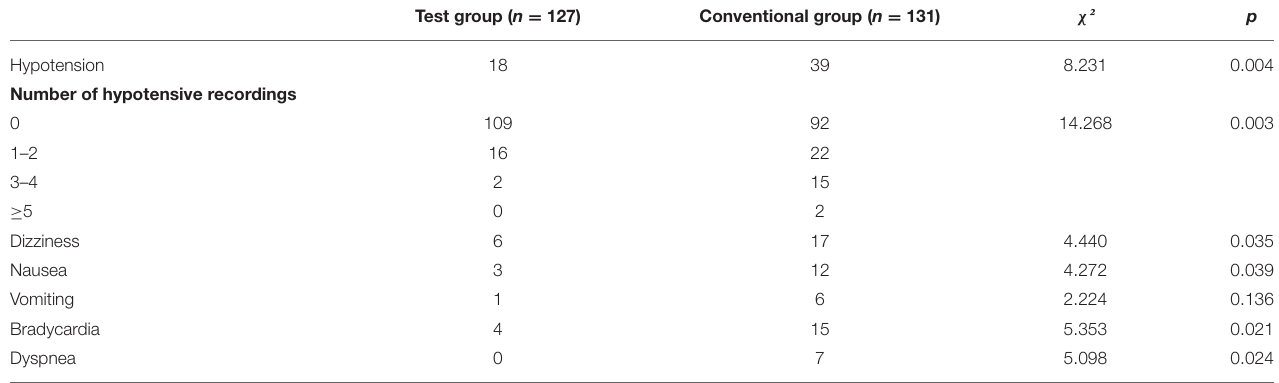
TABLE 3 | Incidence of side effects in parturients.